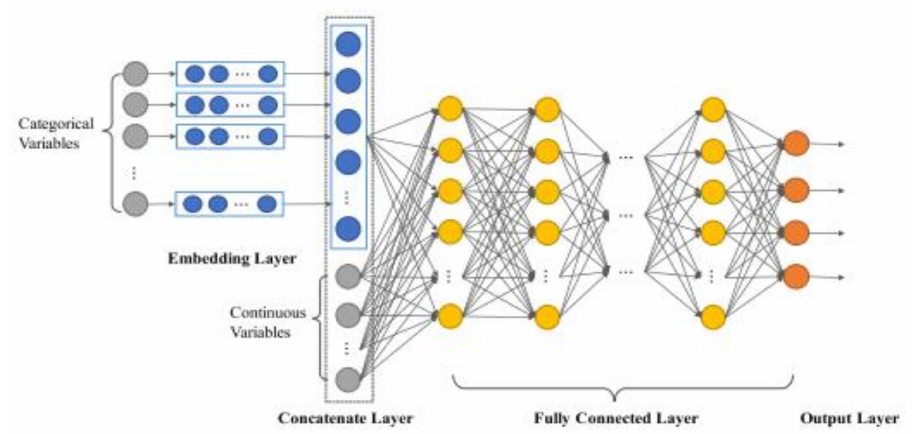
Figure 25. Deep neural network travel prediction framework